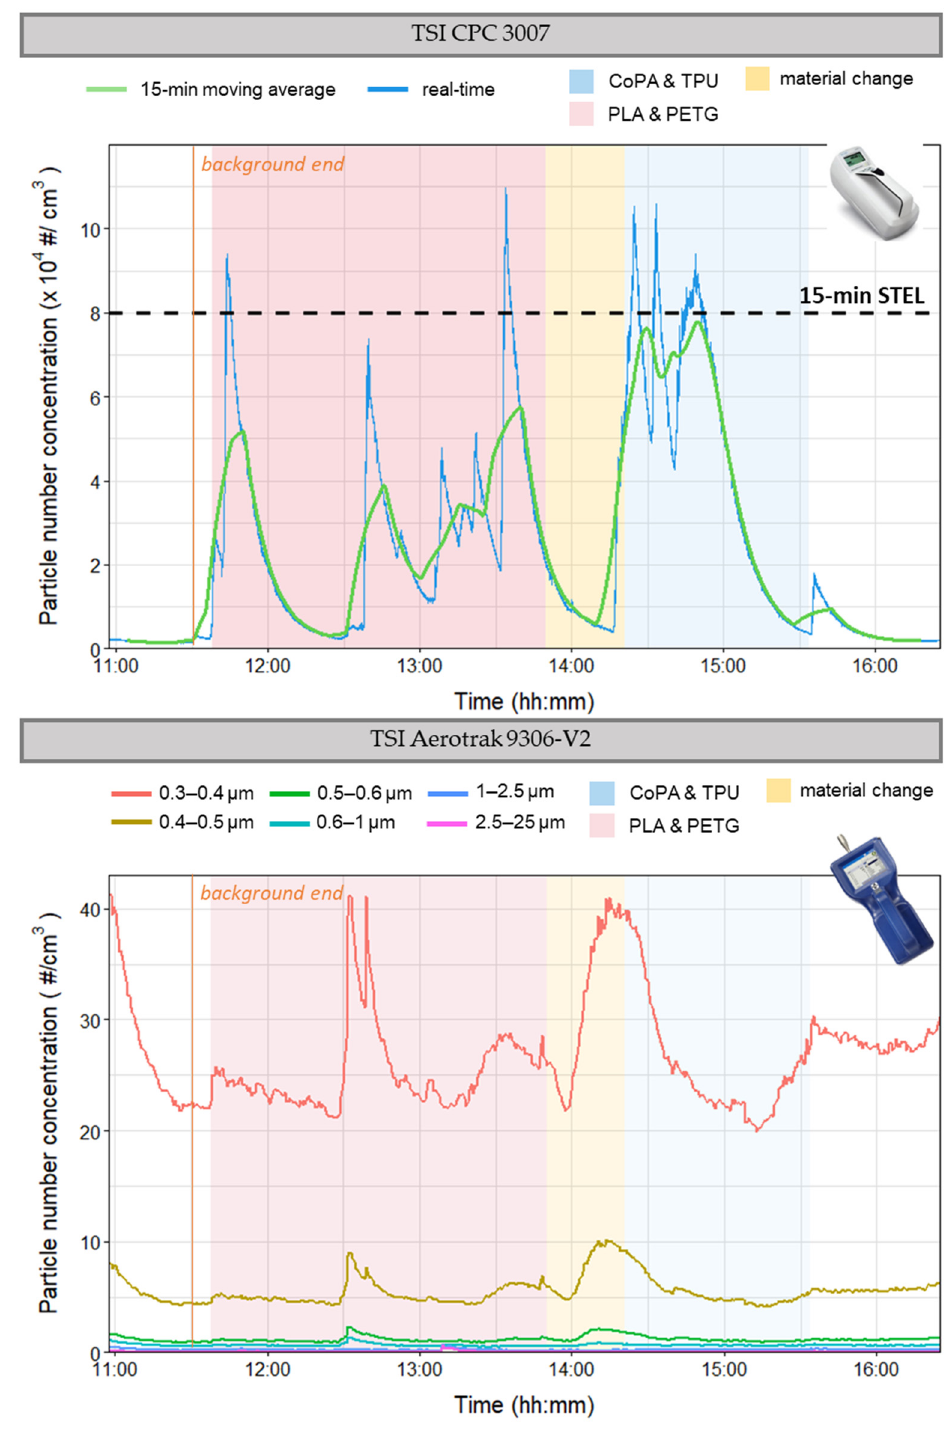
Figure 3. Particle concentrations for Case 2.